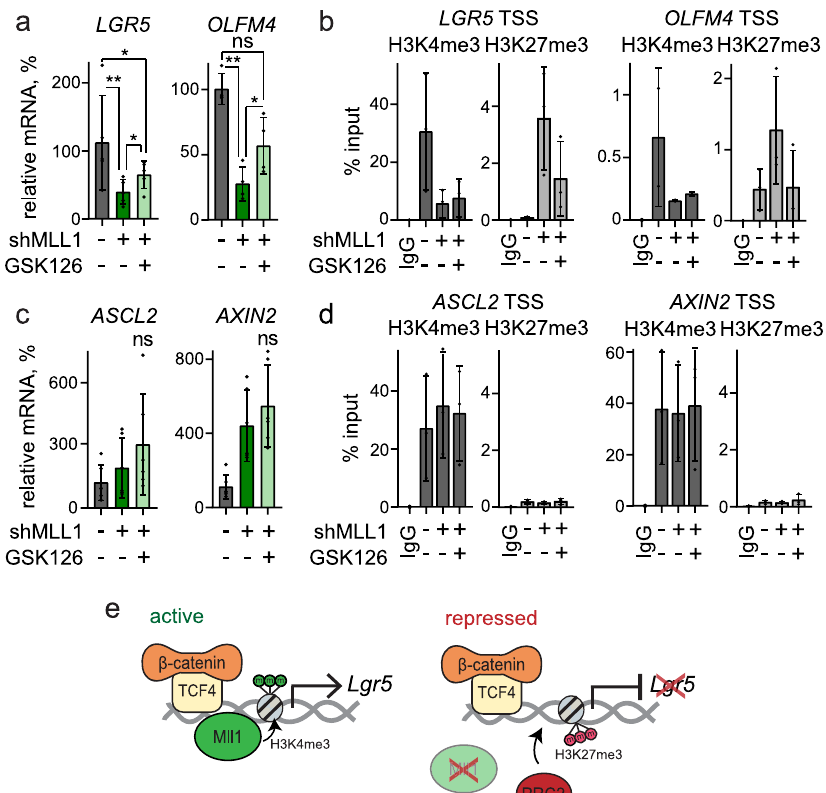
Fig. 6 Mll1 antagonizes PcG-mediated silencing of stem cell genes. a mRNA expression of LGR5 and OLFM4 in control (dark gray), 6d doxycycline- induced shMLL1 human Ls174T cells (dark green), and shMLL1 Ls174T cells following 4-day Gsk126 treatment (light green), n = 4 independent experiments, two-tailed unpaired t -test, LGR5 * p = 0.014, ** p = 0.0016, * p = 0.027; OLFM4 ** p = 0.008, * p = 0.03. Data are presented as mean values